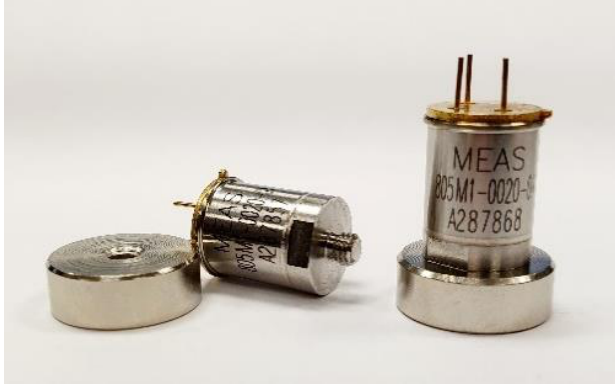
Figure 2. 805M1-0020 accelerometers.